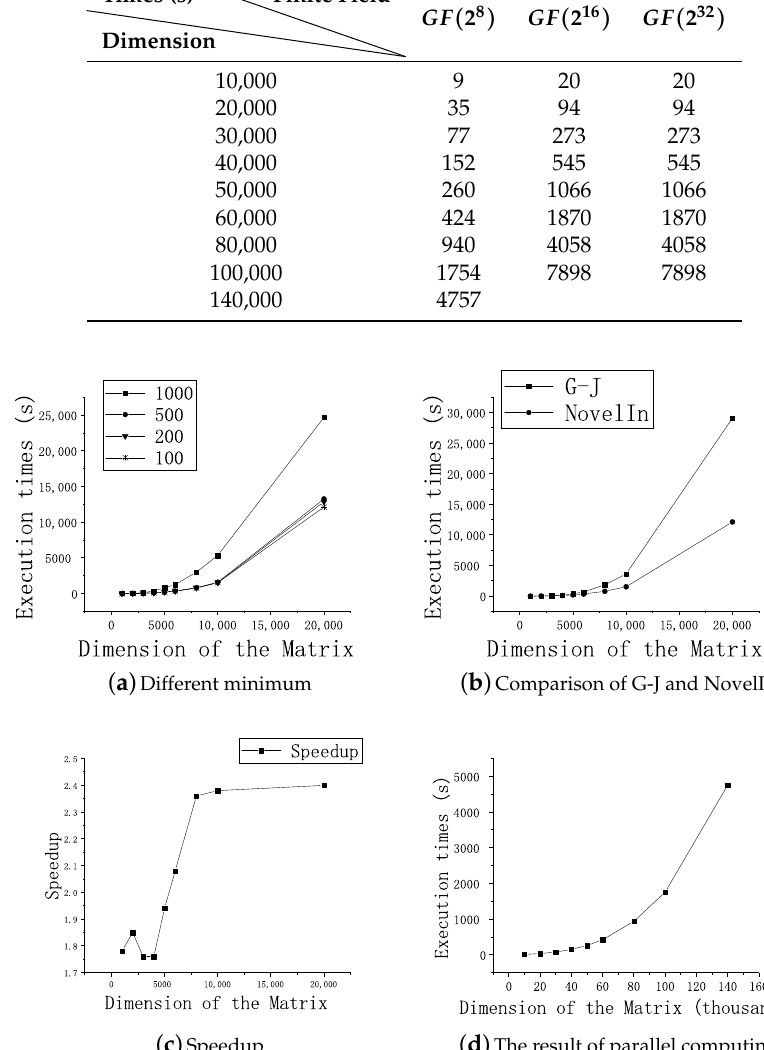
( d ) The result of parallel computing Figure 3. The comparison of G-J and NovelIn and NovelIn’s performance on GF ( 2 8 )